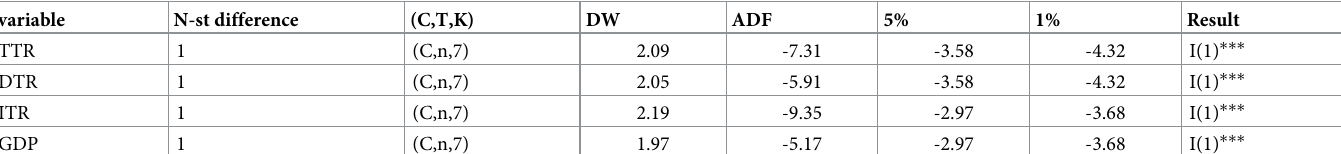
Table 2. Performance of unit root